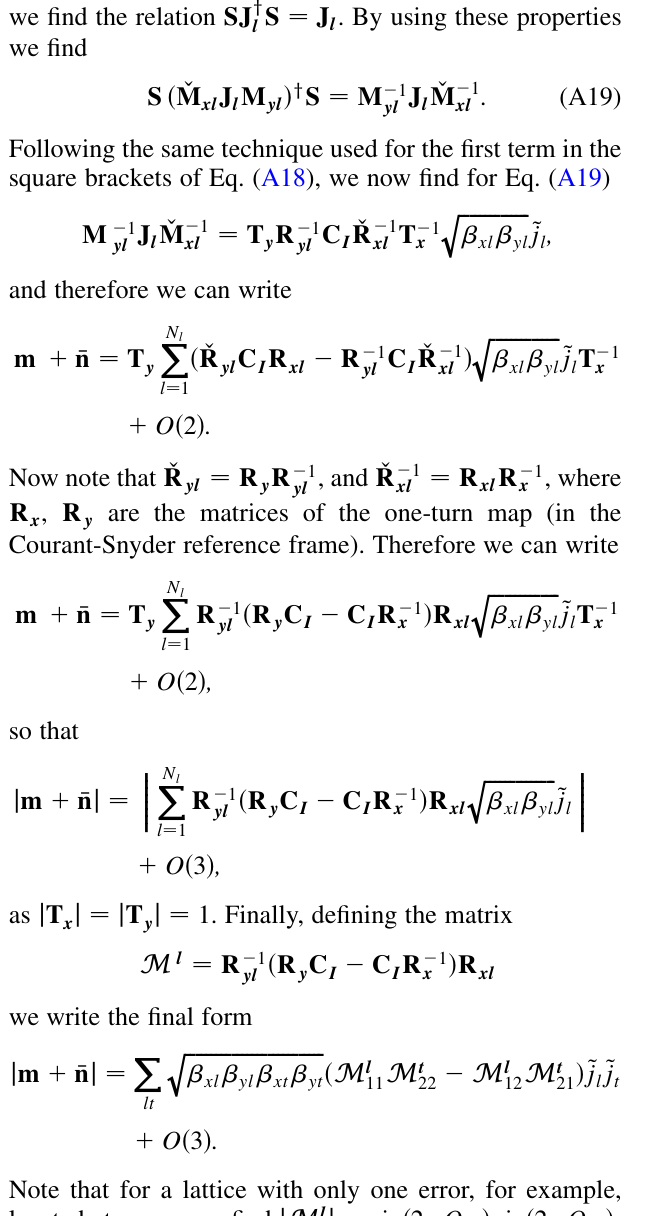
ffiffiffiffiffiffiffiffiffiffiffiffiffiffiffiffiffiffiffiffiffiffiffiffiffiffiffiffiffi